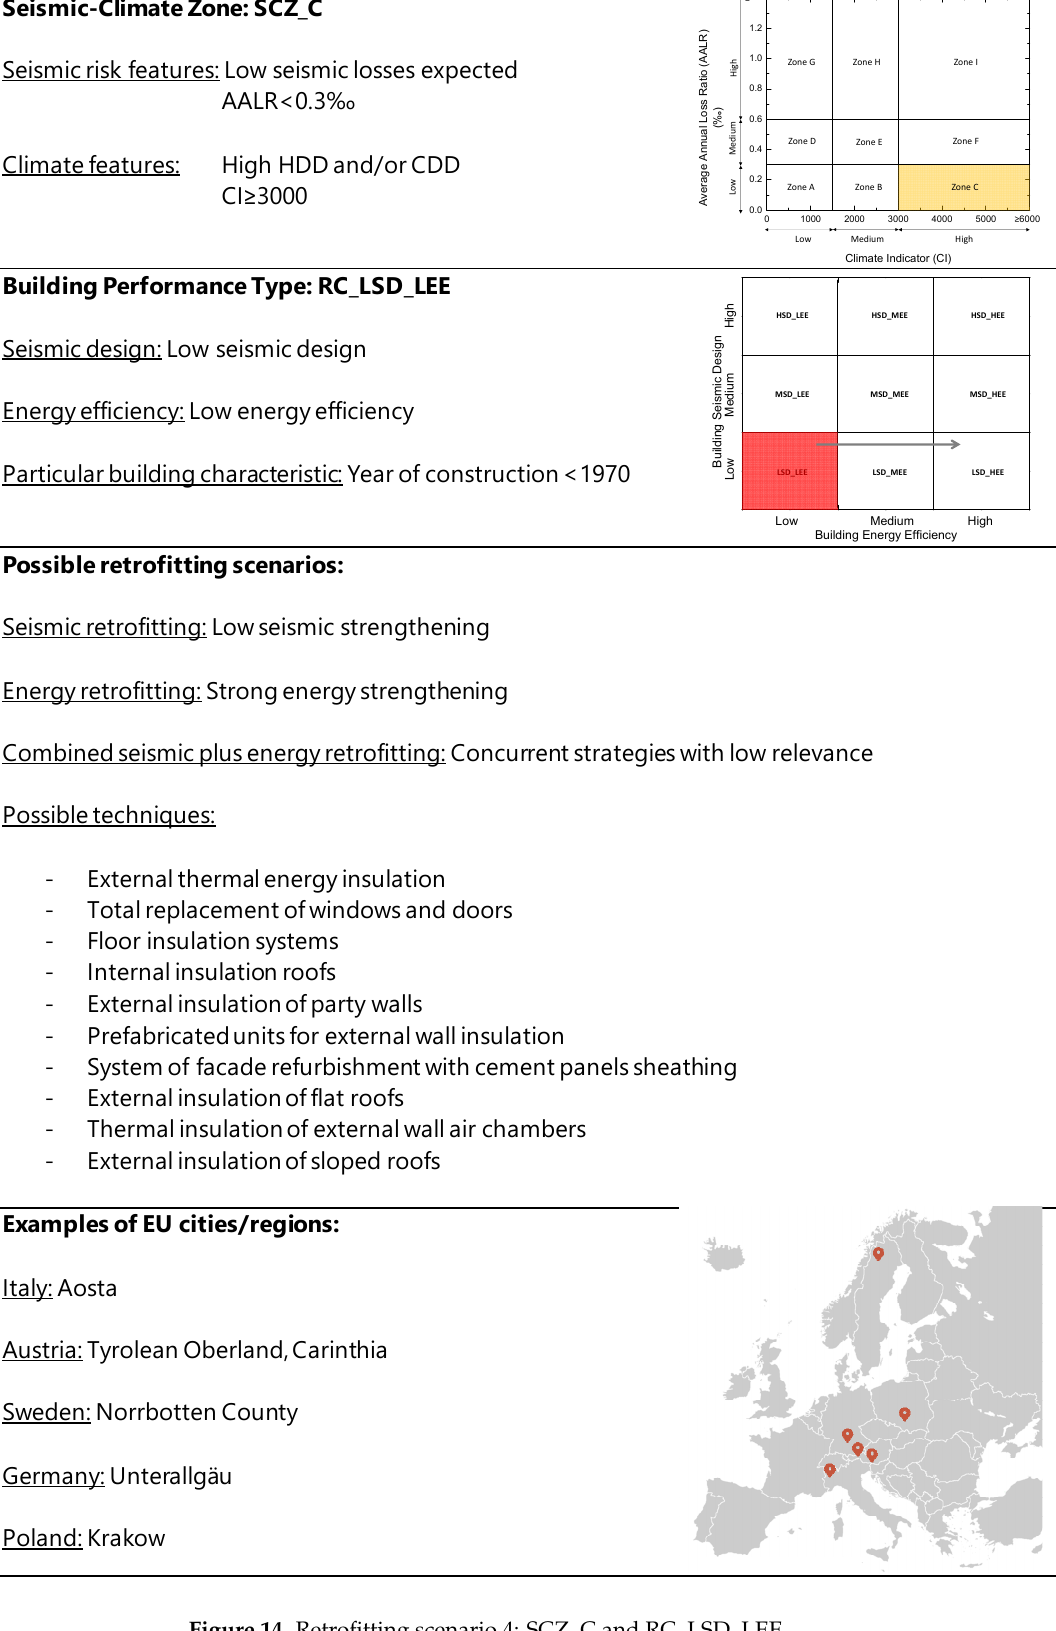
Figure 14. Retrofitting scenario 4: SCZ_C and RC_LSD_LEE.